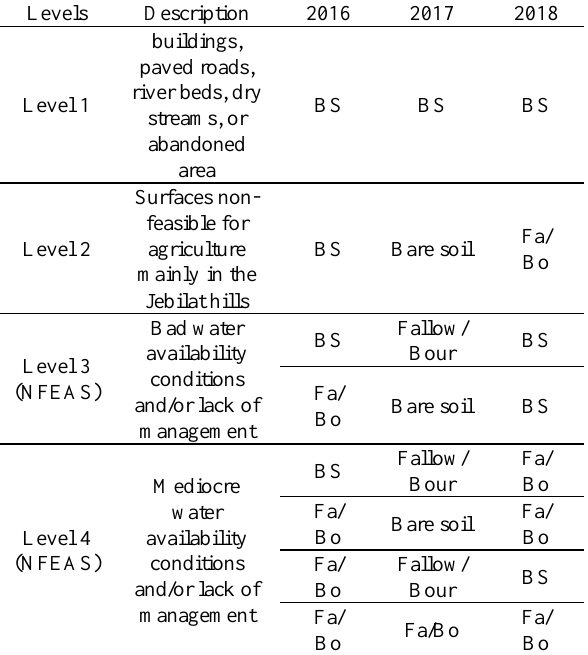
Table 4. Levels representing the type and degree of change as the different possible combinations over the last three